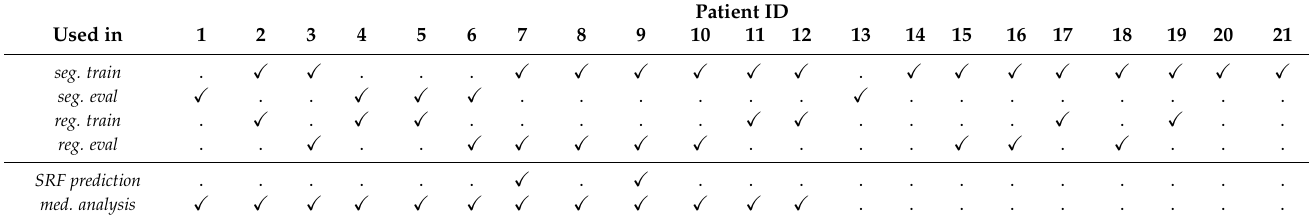
Table 1. We used image data from 21 CSCR patients: seg. train and seg. eval depict patients whose OCTs were used for training (Section 2.2.1) and evaluating (Section 3.1) the SRF segmentation network. reg. train depicts patients, from which FAF, FAG and fundus images were used to train the registration model in [8]. reg. eval depicts patients whose IR and FAF data were used for evaluating the same registration model in our usecase (Section 3.2). SRF prediction depicts patients, for which at least part of their SRF was predicted with our segmentation network during medical analysis. med. analysis lists patients used in our medical analysis (Section 5.1). Please note that segmentation and registration are independent of each other and that the medical analysis is separate from the technical evaluation. Patient ID Used in